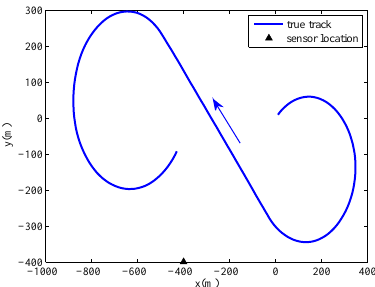
Figure 1. True track of target and sensor location.